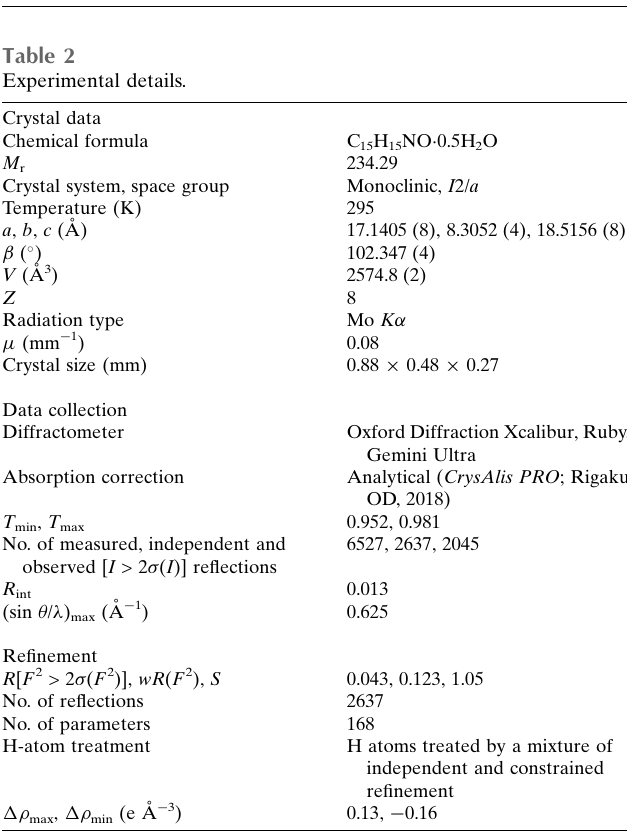
Table 2 Experimental